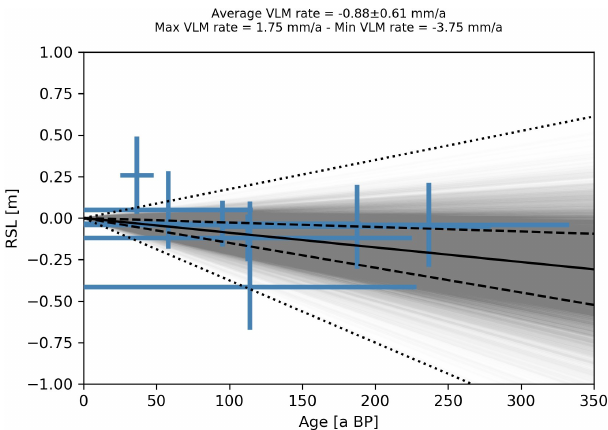
Figure 10. Common Era data points, corrected for 20th-century sea-level rise and GIA uplift (blue crosses). Gray lines show the re- sults of reiterating a linear fit through random normal samples of the blue points. Dotted black lines show the linear fits with maximum and minimum slopes. Dashed black lines show average + standard deviation and average − standard deviation slopes. The solid black line shows the average slope. The Jupyter notebook used to create this graph is available in Rovere et al.